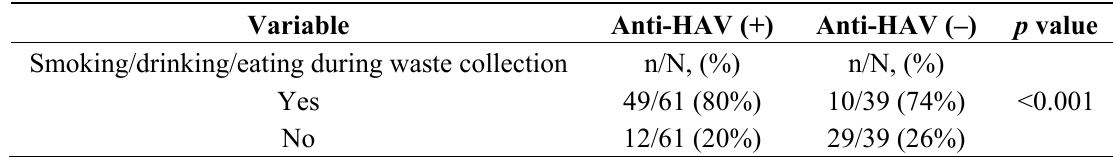
Table 4. Personal behavior during waste collection and HAV infection among waste